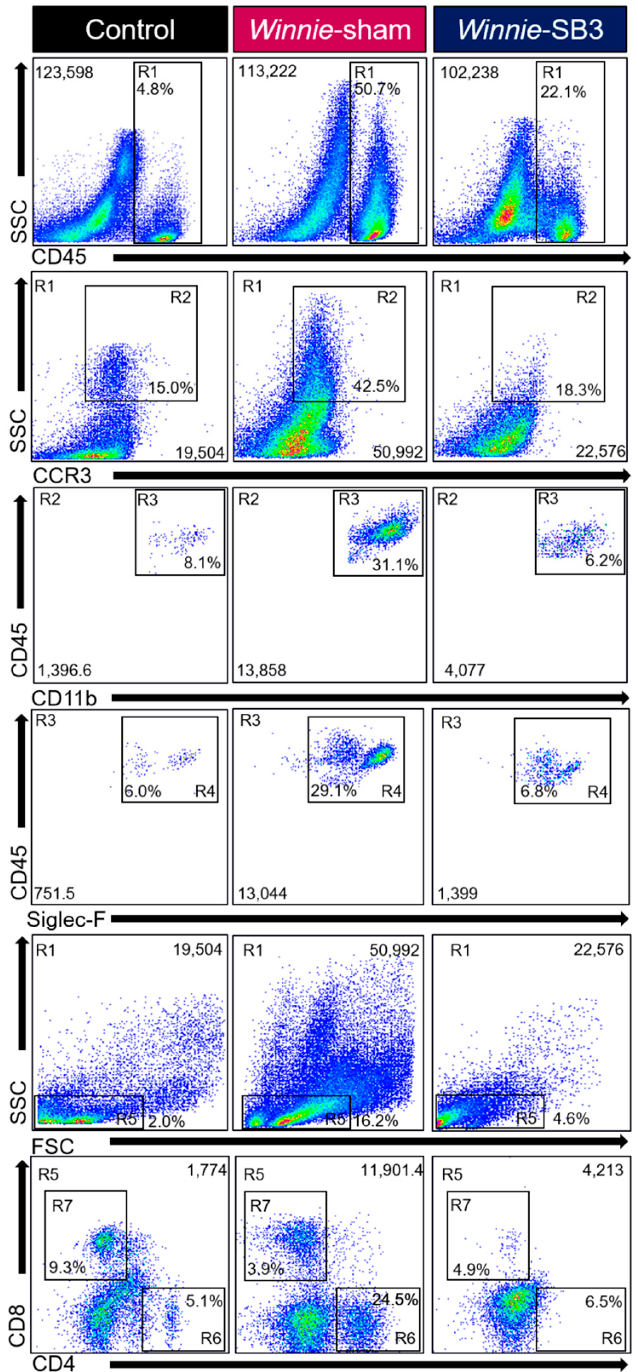
Figure 2. Gating strategy employed to characterize leukocytes, eosinophils, and T-lymphocytes in isolated single-cell suspensions from control, sham-treated, and SB3-treated Winnie animals. Region (R1) Viable cells were gated to isolate leukocytes based on SSC LO/HI against CD45 + cells. Subsequent gating was based on (R2) SSC HI and CCR3 + , followed by (R3) CD11b + and (R4) Siglec-F + expressions to delineate eosinophil subsets. Based on (R1) viable CD45 + subsets, (R5) characterized SSC LO and FSC LO lymphocytes to isolate (R6) CD4 + T helper and (R7) CD8 + cytotoxic T cell subsets.